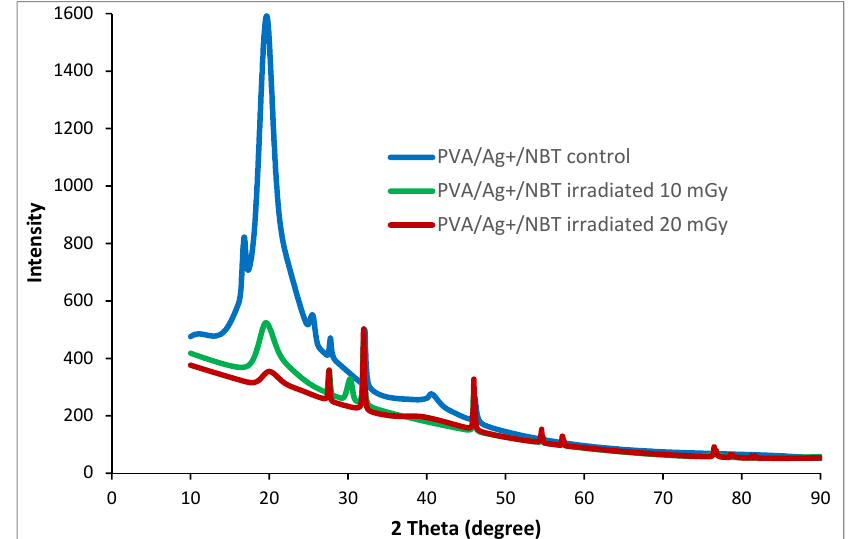
+ /NBT nanocomposite